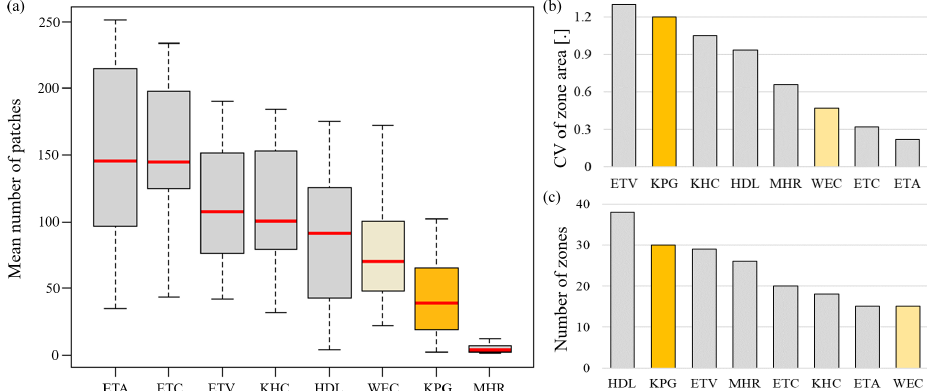
Figure 4. Boxplots of mean number of patches per zone (a) , barplots of CV of zone areas (b) , and barplots of number of constructed zones (c) for each assessed climate classification system, with KPG shown in gold and WEC in light beige. The results of the K–S test were used to determine statistical difference of distributions compared to WEC. Systems whose distributions of mean number of patches were not statistically different from that of WEC are underlined.